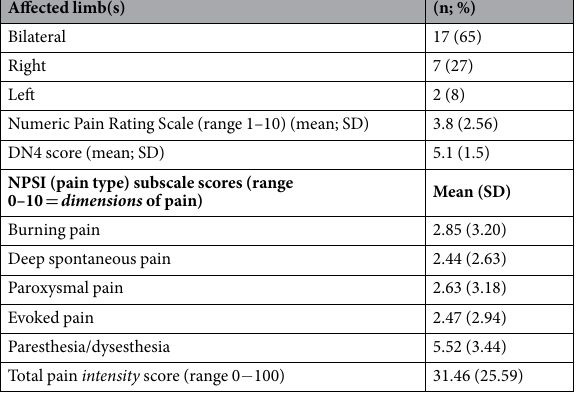
Table 2. Patient’s symptoms. DN4 = Douleur Neuropathique 4 - Neuropathic Pain questionnaire; NPSI = Neuropathic Pain Symptom Inventory.